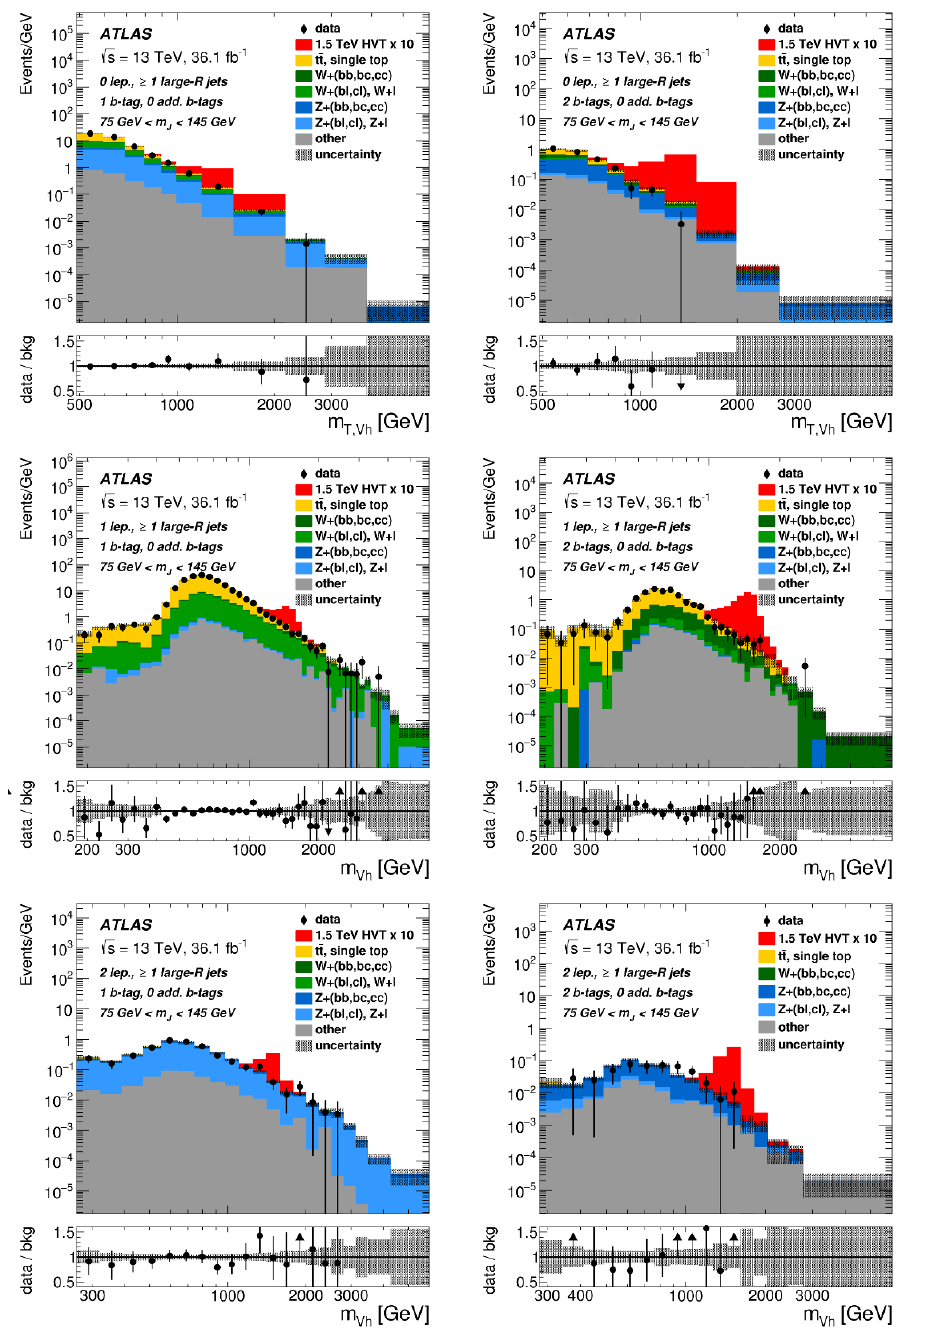
Figure 3. Event distributions of m T ;V h for the 0-lepton channel, and m V h for the 1-lepton and 2-lepton channels in the merged categories. The quantity on the vertical axis is the num- ber of data events divided by the bin width in GeV. The background prediction is shown after a background-only maximum-likelihood (cid:12)t to the data. The signal for the benchmark HVT Model A with m V 0 = 1 : 5 TeV is normalised to 10 times the theoretical cross-section. The background uncer- tainty band shown includes both the statistical and systematic uncertainties after the (cid:12)t added in quadrature. The lower panels show the ratio of the observed data to the estimated SM background.